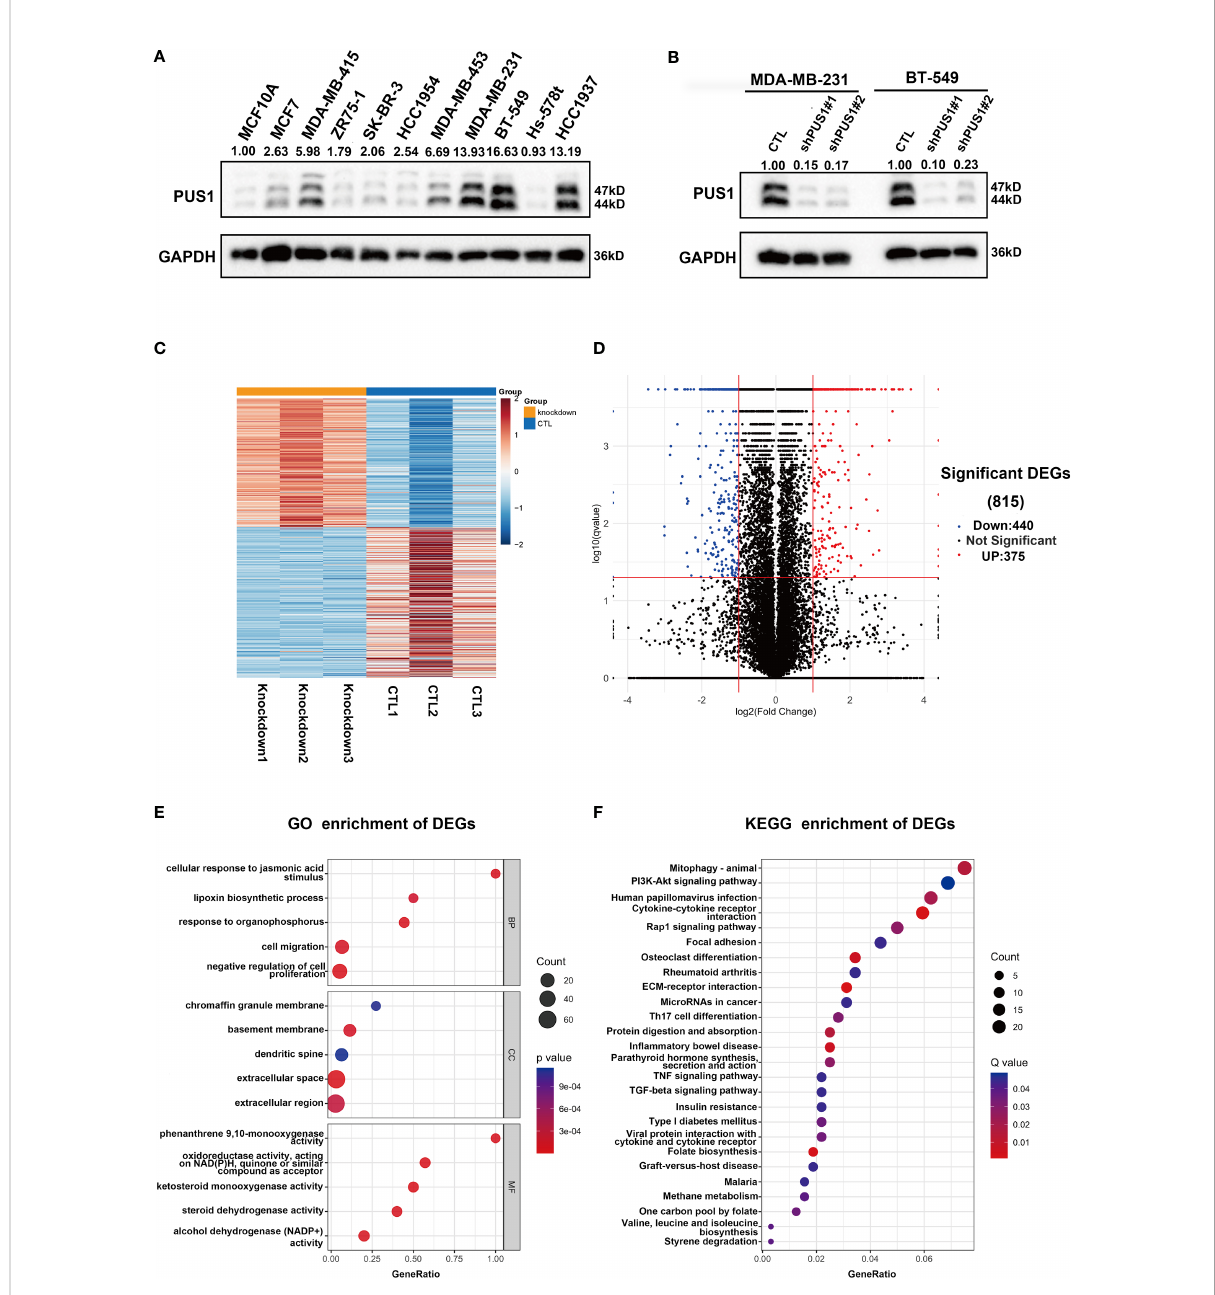
FIGURE 3 PUS1 might involve in tumor progression by in fl uencing a series of cancer related biological process and pathways. (A) Relative protein level of PUS1 in normal mammary epithelial cell MCF10A and a series of breast cancer cell line validated by western blot assay. The breast cell lines representing the genomic features of the main breast cancer subtypes were selected, including luminal MCF-7, MDA-MB-415, ZR-75-1; Her2 positive, SK-BR-3, HCC1954 and triple negative subtype MDA-MB-453, MDA-MB-231, BT-549, Hs-578T, HCC1937. Three TNBC cell lines relative strongly expressed PUS1 including MDA-MB-231, BT-549 and HCC1937. (B) The stable silencing of PUS1 expression by lentivirus infection in MDA-MB-231 and BT-549 cells. Western blot analysis showed that the protein level of PUS1was remarkably knocked down in the shPUS1 groups compared with CTL groups. CTL, cells transfected with control shRNA lentivirus; shPUS1, cells transfected with PUS1 shRNA lentivirus. (C, D) The heatmap and volcano plot of DEGs between the PUS1 knockdown MDA-MB-231 cells and negative control group (E, F) The GO enrichment and KEGG enrichment Analysis of the DEGs between PUS1 knockdown high and low expression groups. DEGs, differentially expressed genes. GO, Gene ontology. KEGG, Kyoto Encyclopedia of Genes and